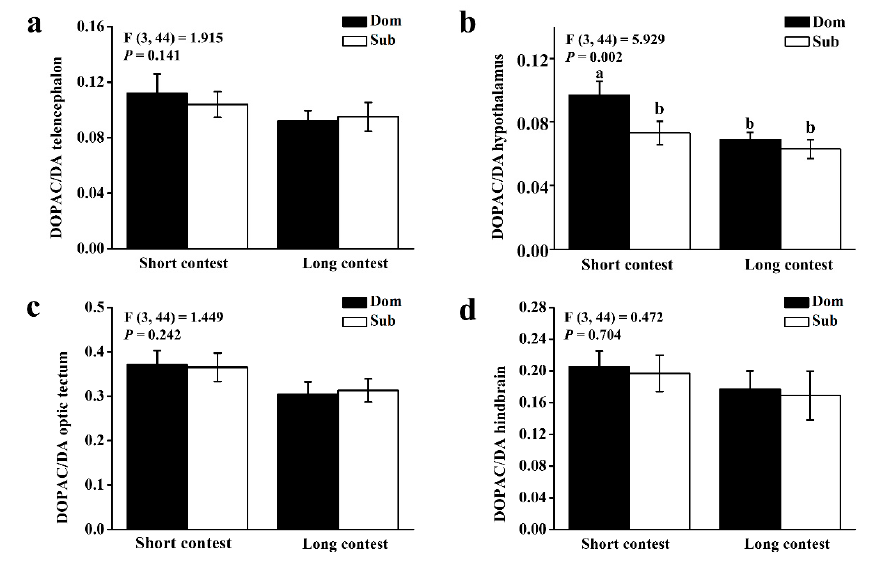
Figure 3. 3, 4-dihydroxyphenylacetic acid (DOPAC) / dopamine (DA) ratios of ( a ) telencephalon, ( b )